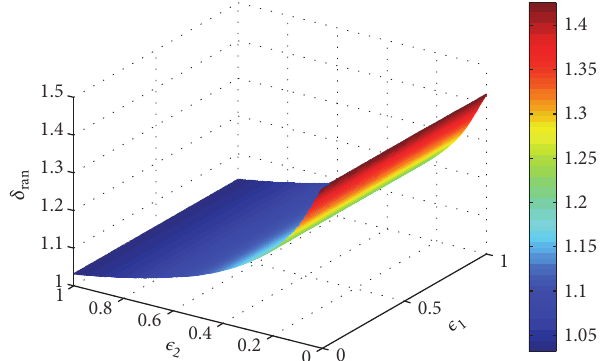
Figure 6: The simulation of correlation between pair ( 𝜖 1 , 𝜖 2 ) and 𝛿 ran .